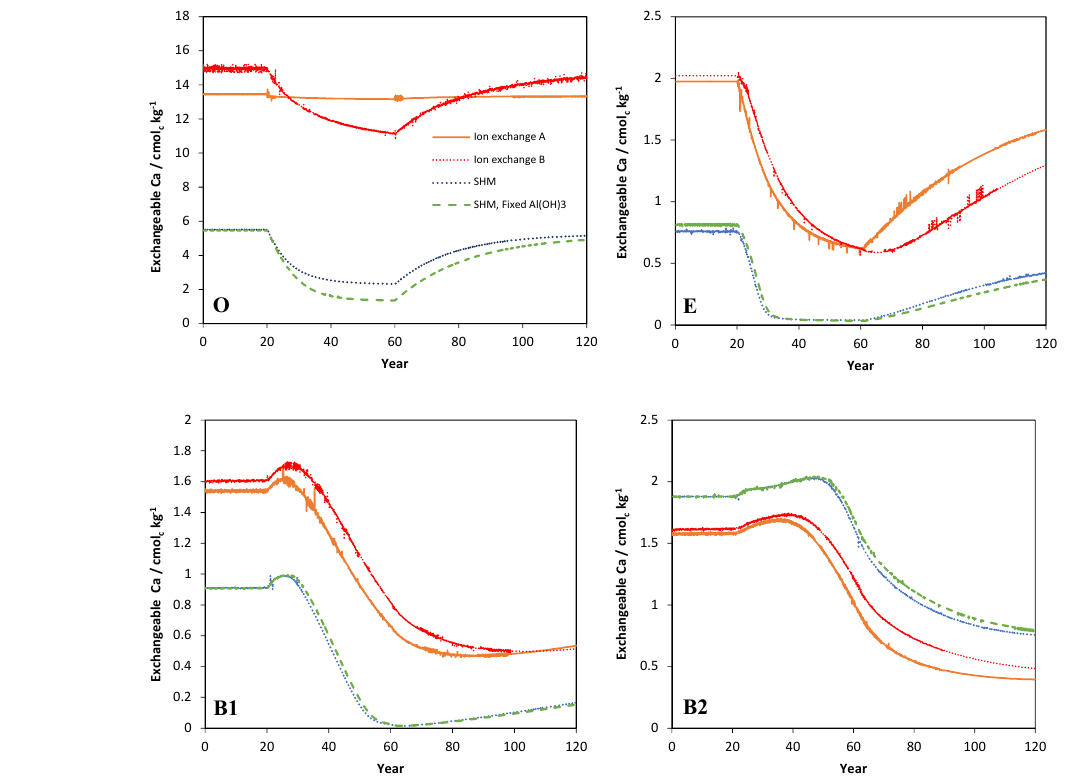
Figure 3. Simulated values of exchangeable (sorbed) Ca 2 + in the four soil layers (O, E, B1, B2) as a function of time for the four models considered in the Acid scenario. For model set-up and scenario parameters, see